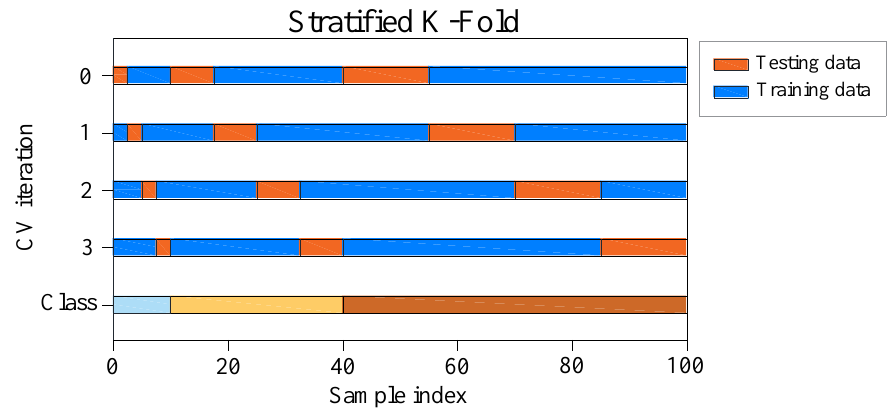
Figure 4. Schematic diagram of stratified K-fold cross-validation.